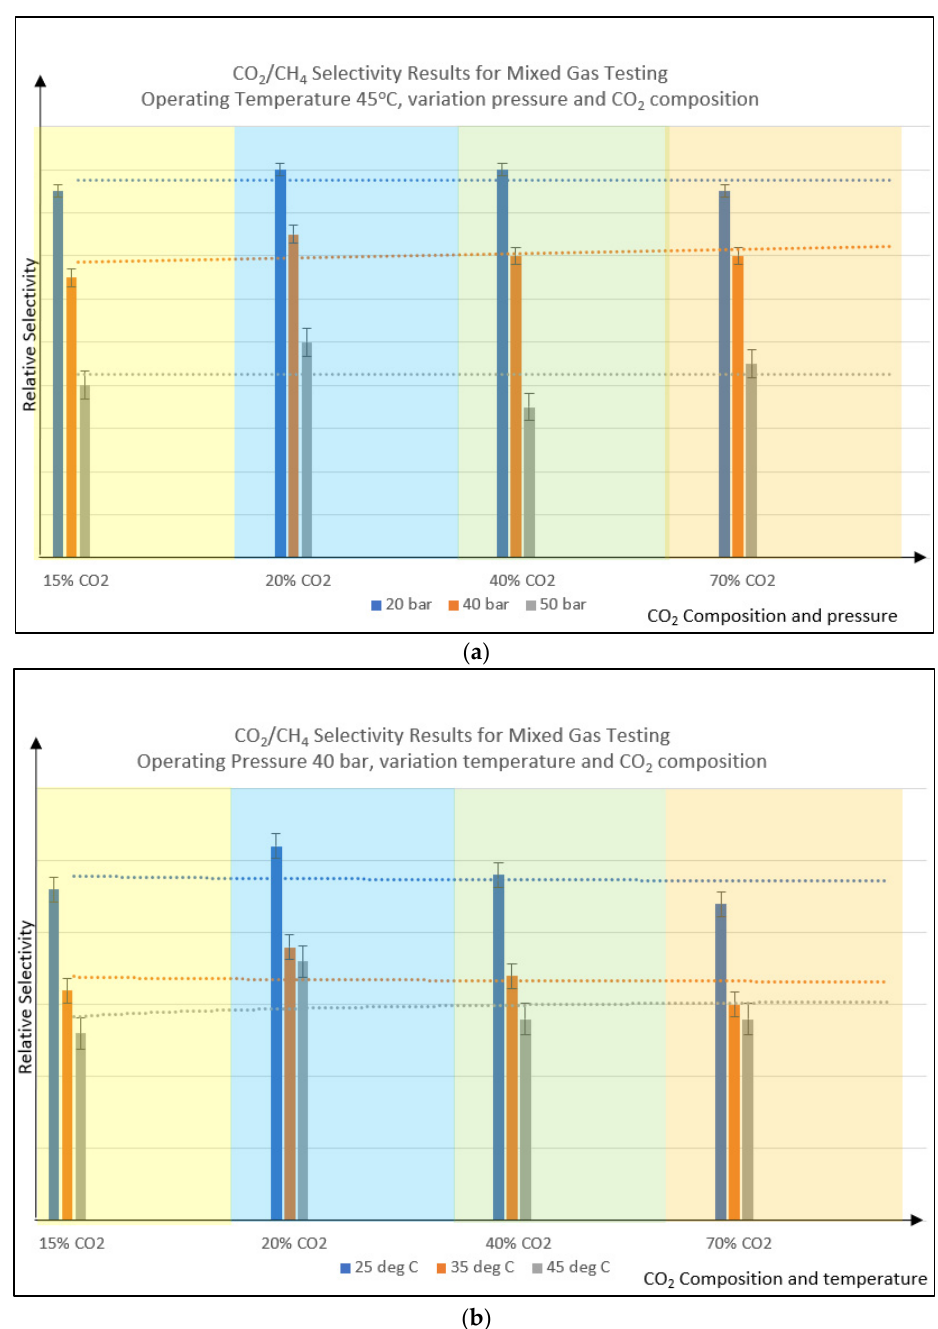
Figure 9. Relative selectivity vs. variation of CO 2 feed composition; varies operating pressure ( a ) and varies operating temperature ( b ). Dotted line is the trendline as a guide.